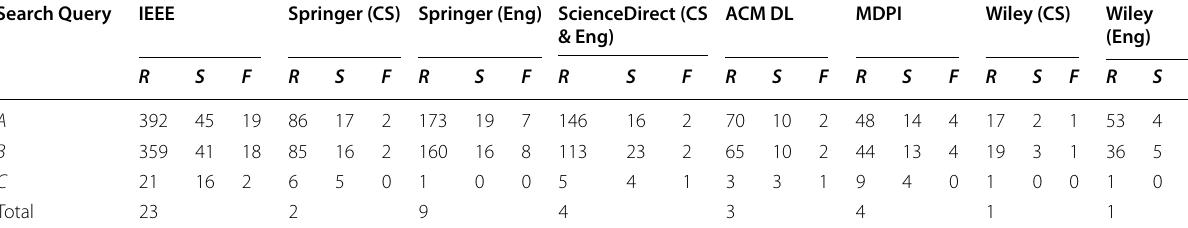
Table 1 Number of references retrieved during critical analysis for each search engine Search Query